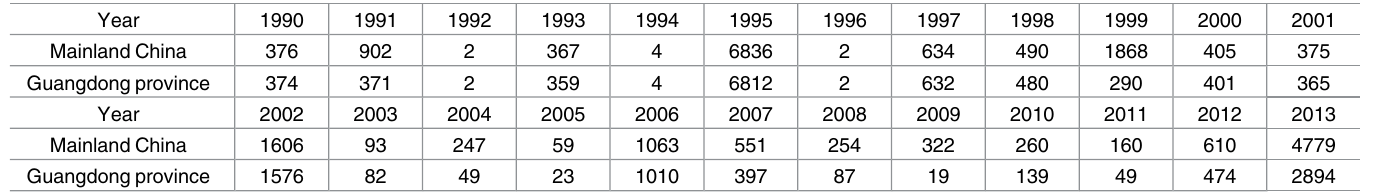
Table 1. Comparison dengue casesbetween mainland China and Guangdong from 1990 to 2013. The mainlandChinadata are from Refs. [8] and the Guangdongdata are from Refs. [9,